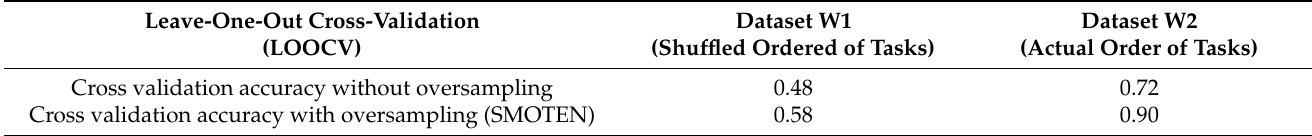
Table 1. Performance of prediction models of final user satisfaction for a travel agency website. Leave-One-Out